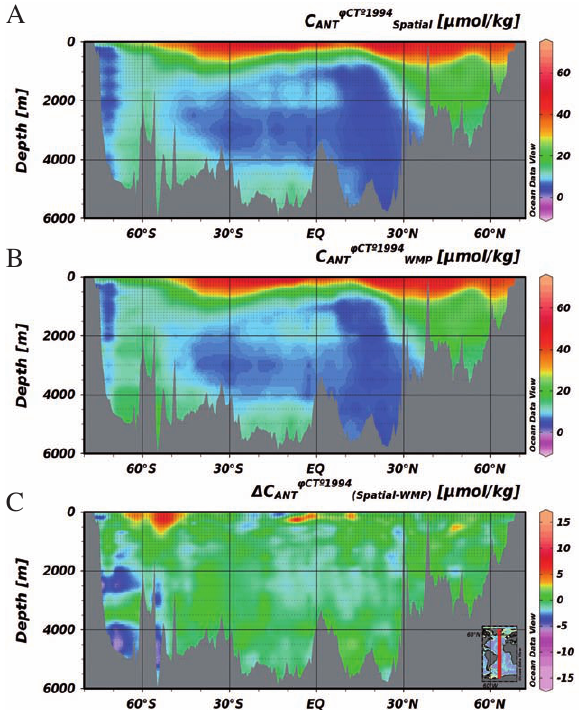
Fig . 6. – C (µmol kg -1 ) determined by the j C ANT 28ºW using spatial interpolation (A) and WMP interpolation (B). Residuals between the two interpolations are shown (C) as spatially interpolated minus WMP